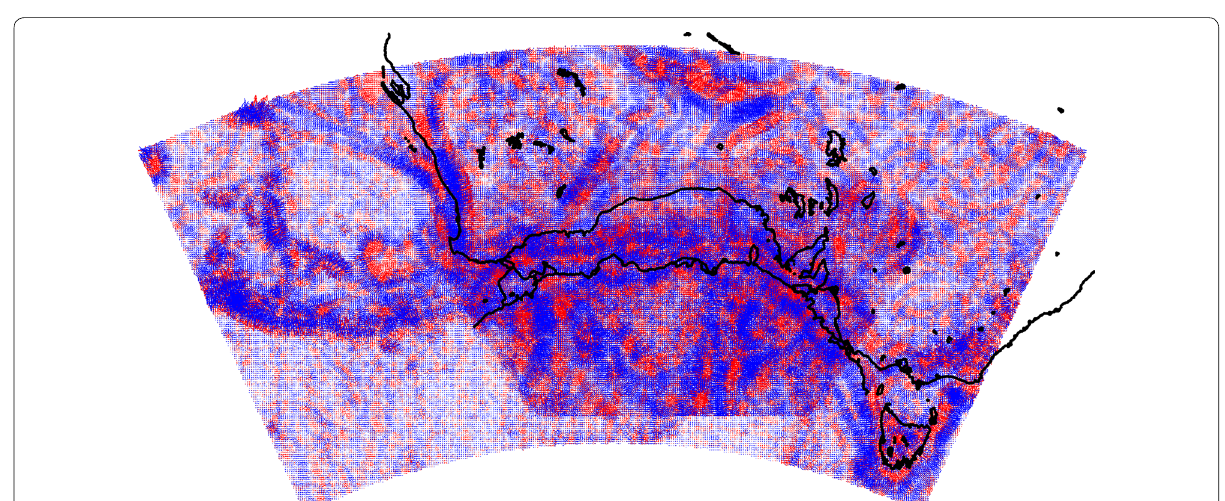
Fig. 19 A compound from Figs. 10 and 18 with a shift in latitude and slight shift in longitude to achieve experimentally, by eye, the best fit of the two parts of the signal with vd from Antarctica to South Australia. It supports conclusions in von Frese et al.